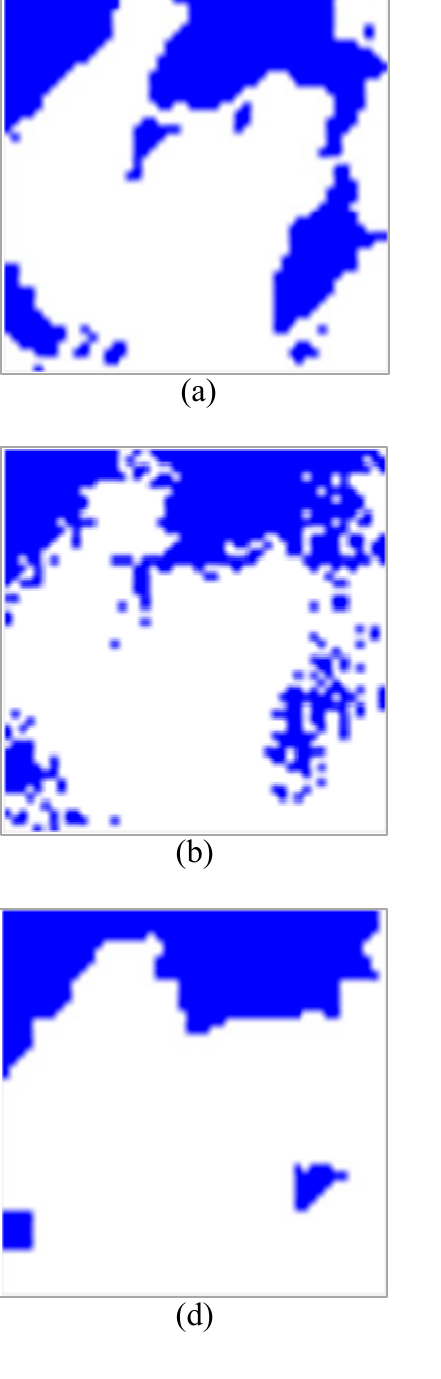
Figure 9. Zoom for small part 1 of inundation reference image and different SUIM results for Yueyang. ( a ) Inundation reference image; ( b ) BPNN ‐ SUIM; ( c ) SVM ‐ SUIM; ( d ) SAM ‐ SUIM; ( e ) SAMENN ‐ SUIM.